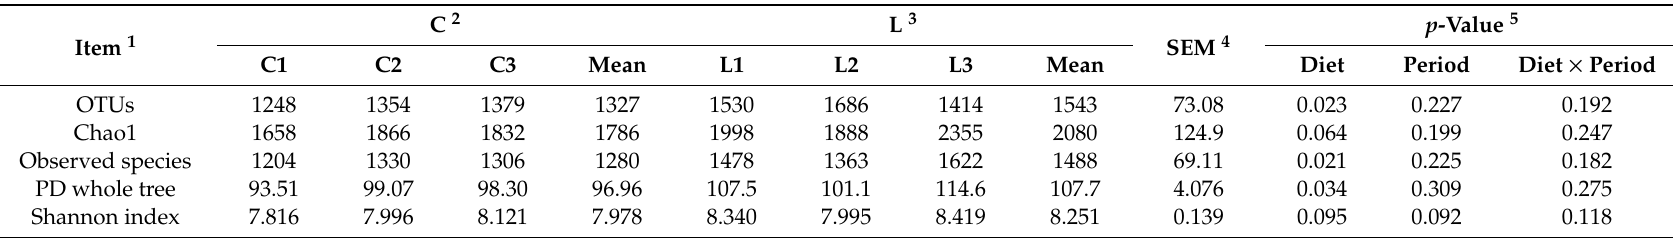
Table 2. The number of operational taxonomic units (OTUs), mean richness and evenness estimates for rumen samples collected at three monthly intervals in two diet